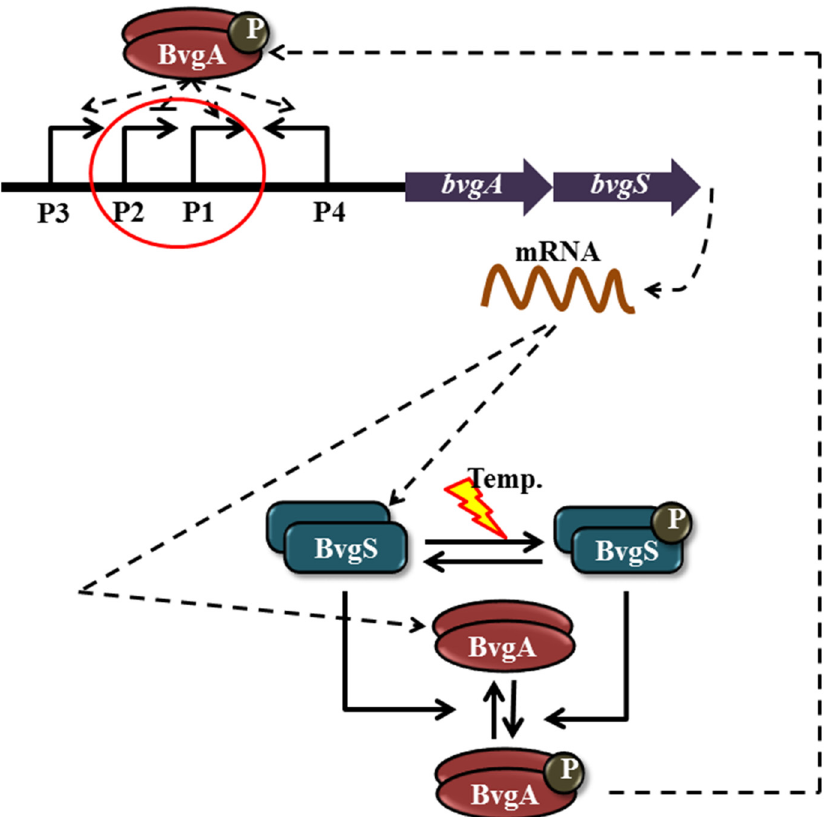
Fig 1. BvgAS signal transduction motif. The signal transduction motif is composed of the phosphotransfer and autoregulation modules. The temperature acts as inducer of the autophosphorylation of the dimer of the sensor kinase protein BvgS (blue). Similarly, dimerized BvgA represents for response regulator in red. P in black sphere stands for phosphate group. Note that, sensor kinase acts both as source and sink for the phosphate